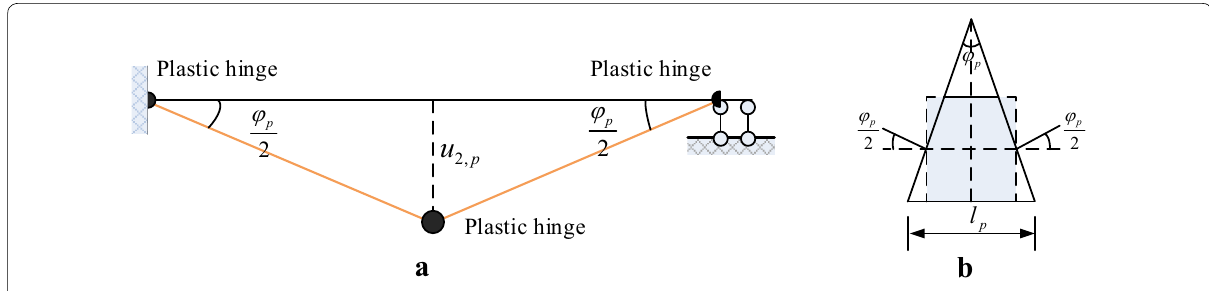
Fig. 5 a Plastic deflections of clamped column with plastic hinge and b Schematic of the plastic